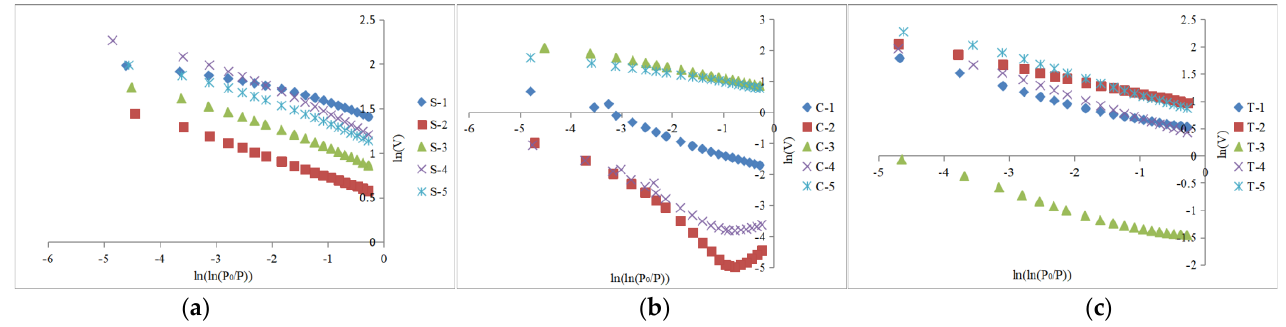
Figure 13. FHH fractal models of shale, coal, and tight sandstone samples using LP-N 2 GA data. ( a ) Shale samples. ( b ) Coal samples. ( c ) Tight sandstone samples. Table 3. FHH fractal model and fractal dimension of shale, coal, and tight sandstone samples.